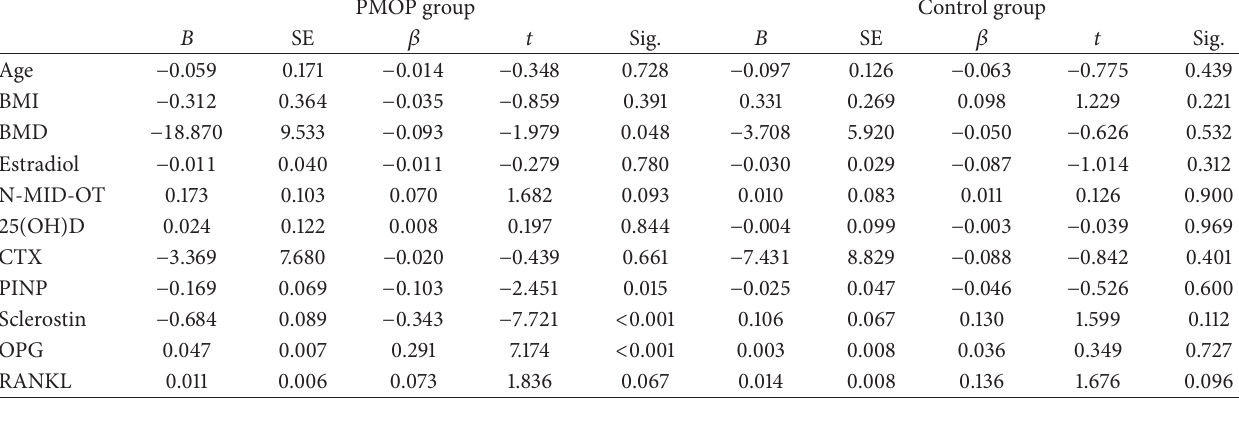
Table 3: Result for multiple regressions in PMOP group and in control group.